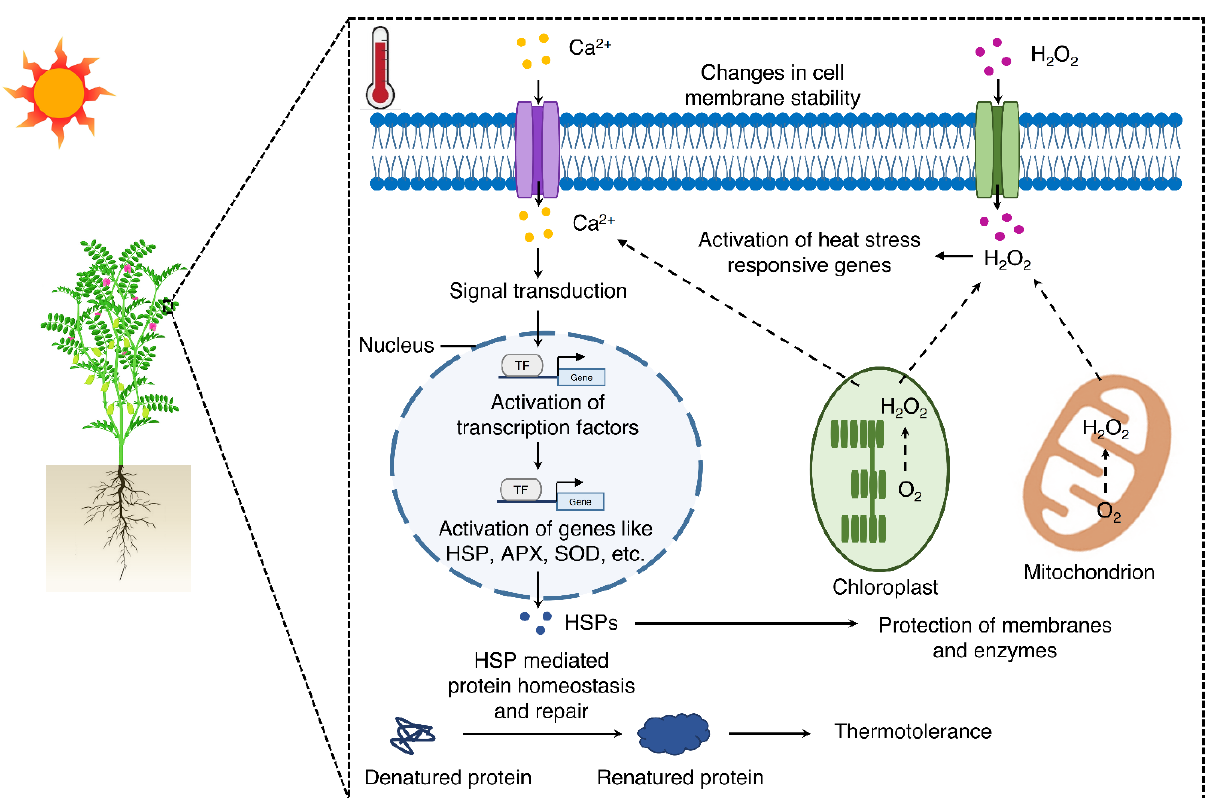
Figure 5. Schematic illustration of the putative regulatory networks induced in response to heat stress in chickpea. The figure summarizes the results obtained in the current study and some hypothesized mechanisms. Abbreviation for genes: HSP, heat shock protein; APX, ascorbate peroxidase; SOD, superoxide dismutase. Abbreviation for secondary messengers: Ca 2+ , calcium; H 2 O 2 , hydrogen peroxide.